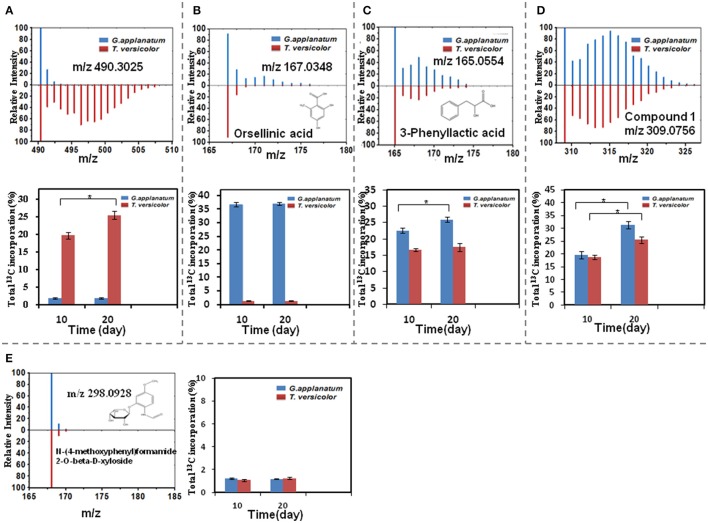
A comparison of relative MS intensity suggests that the induced features have 13C incorporation with time. (A–D) Upper figures: representative mass spectral data for 10 day time point showing that mass intensity caused by 13C incorporation in the mono-culture of T. versicolor or G. applanatum, Lower figures: comparison of total 13C incorporation shows that induced feature was produced by either T. versicolor or G. applanatum, or both. Data show the mean with error bars indicating standard deviation calculated from three independent replicates (*P ≤ 0.05, t-test). (E) There was no 13C incorporation for N-(4-methoxyphenyl)formamide 2-O-beta-D-xyloside on day 10 and 20.